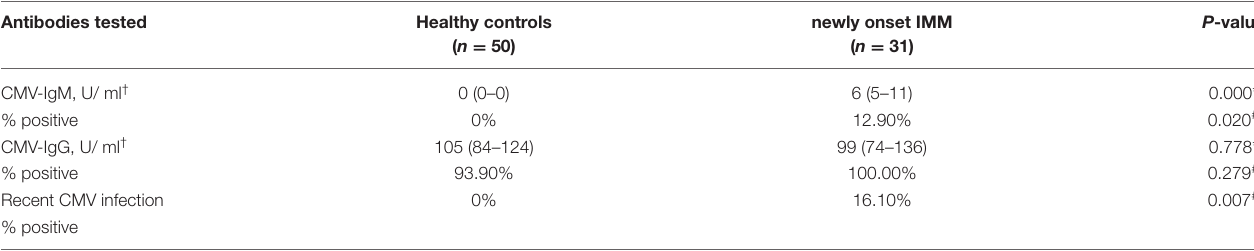
TABLE 3 | Distribution of CMV antibody profile in healthy individuals, new-onset IIM patients. Antibodies